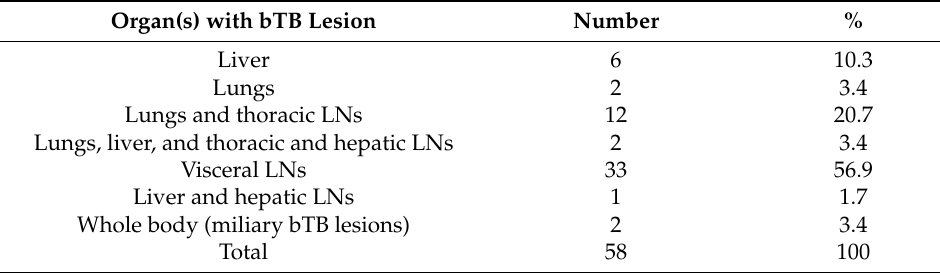
Table 2. Frequency of body organ(s) with bTB